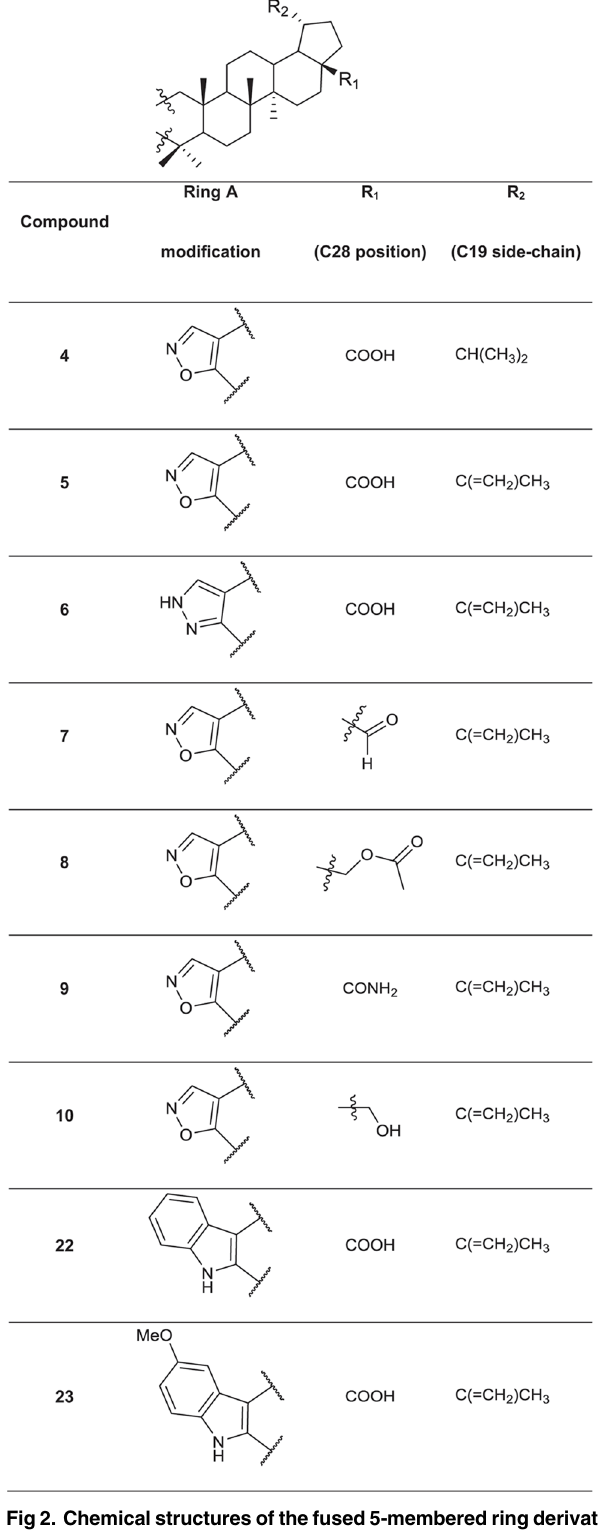
Fig 2. Chemical structures of the fused 5-membered ring derivatives of betulinic